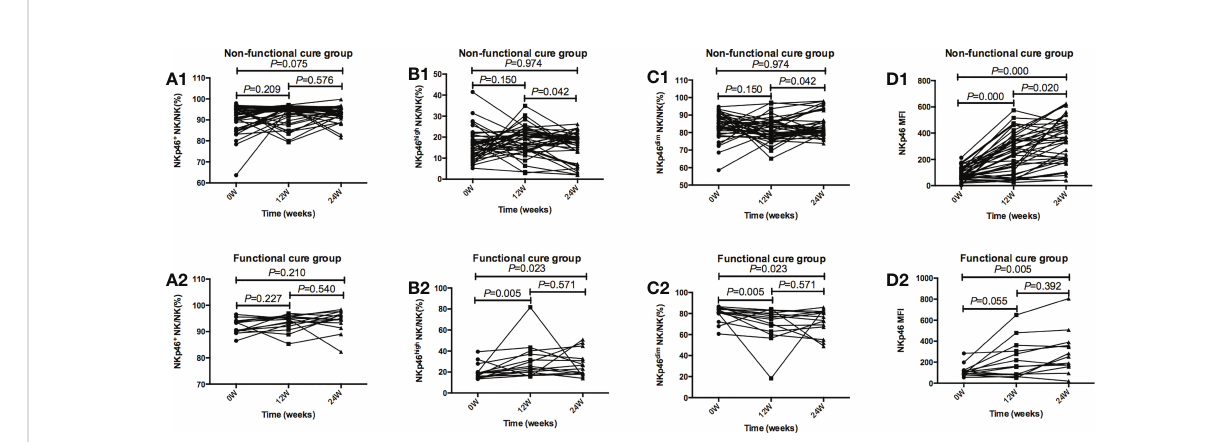
FIGURE 4 Tendencies of NK cells frequency and function, including NKp46 NK/NK%, NKp46high NK/NK%, NKp46dim NK/NK%, and NKp46MFI at baseline and after 12 and 24 weeks of treatment in the Functional cure group and Non-functional-cure group. (A1-D1) Tendencies of NKp46 NK/NK% (A1) , NKp46high NK/NK%(B1), NKp46dim NK/NK% (C1) , and NKp46MFI (D1) at baseline and after 12 and 24 weeks of treatment in the Non- functional-cure group. (A2-D2) Tendencies of NKp46 NK/NK% (A2) , NKp46high NK/NK% (B2) , NKp46dim NK/NK% (C2) , and NKp46MFI (D2) at baseline and after 12 and 24 weeks of treatment in the Functional cure group. p values for multiplicity were ajusted by Bonferroni, and P < 0.016 was denti fifi ed as signi fifi cant statistical